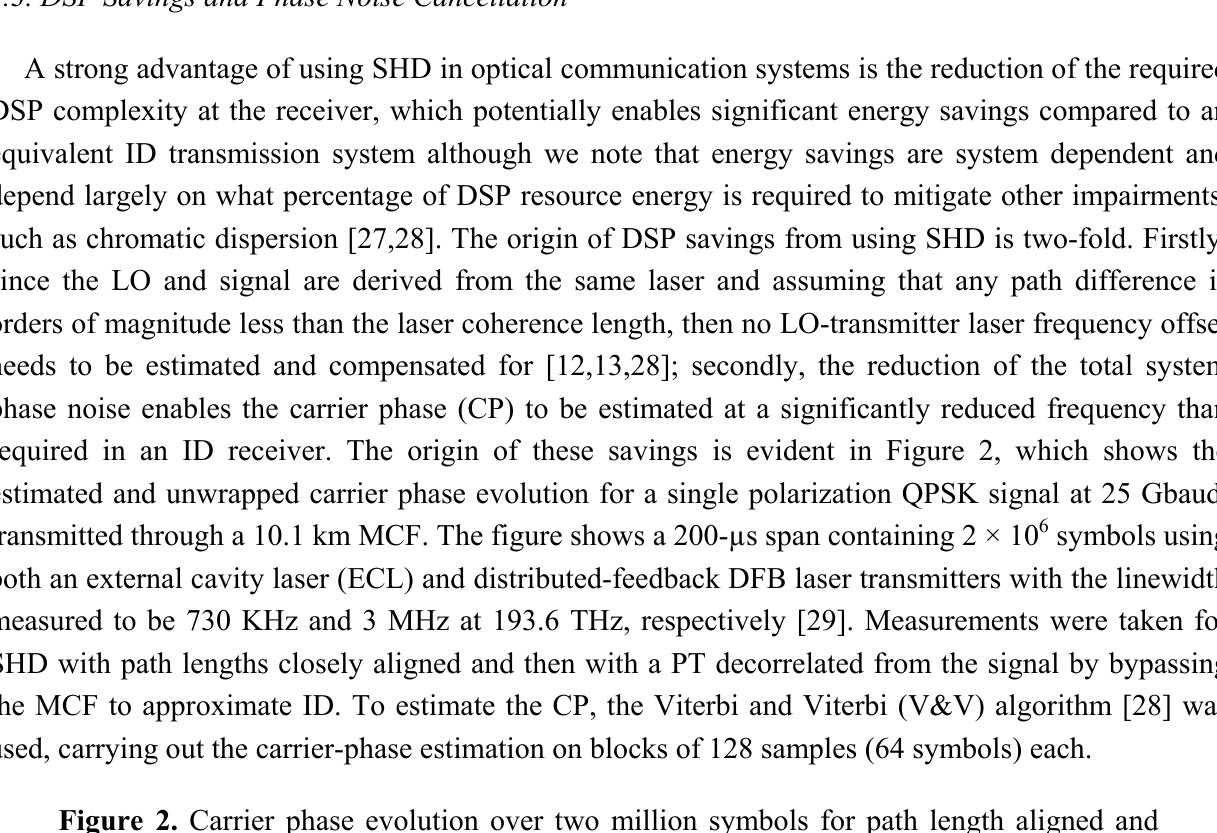
Figure 2. Carrier phase evolution over two million symbols for path length aligned and misaligned SDM-SHD for both the external cavity laser (ECL) and DFB laser